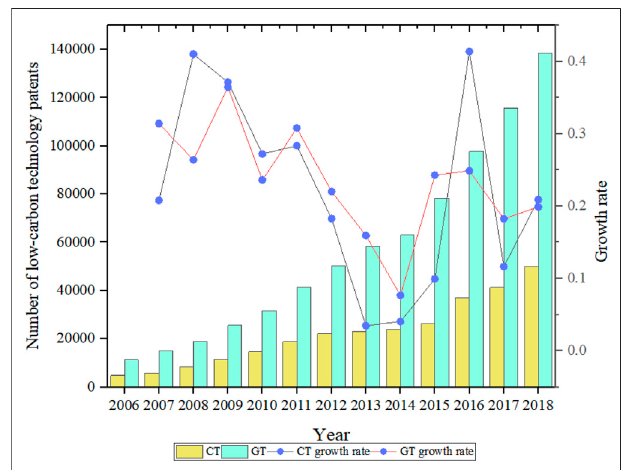
FIGURE 2 | Patent applications and the growth rate of clean and gray technologies in China from 2006 to